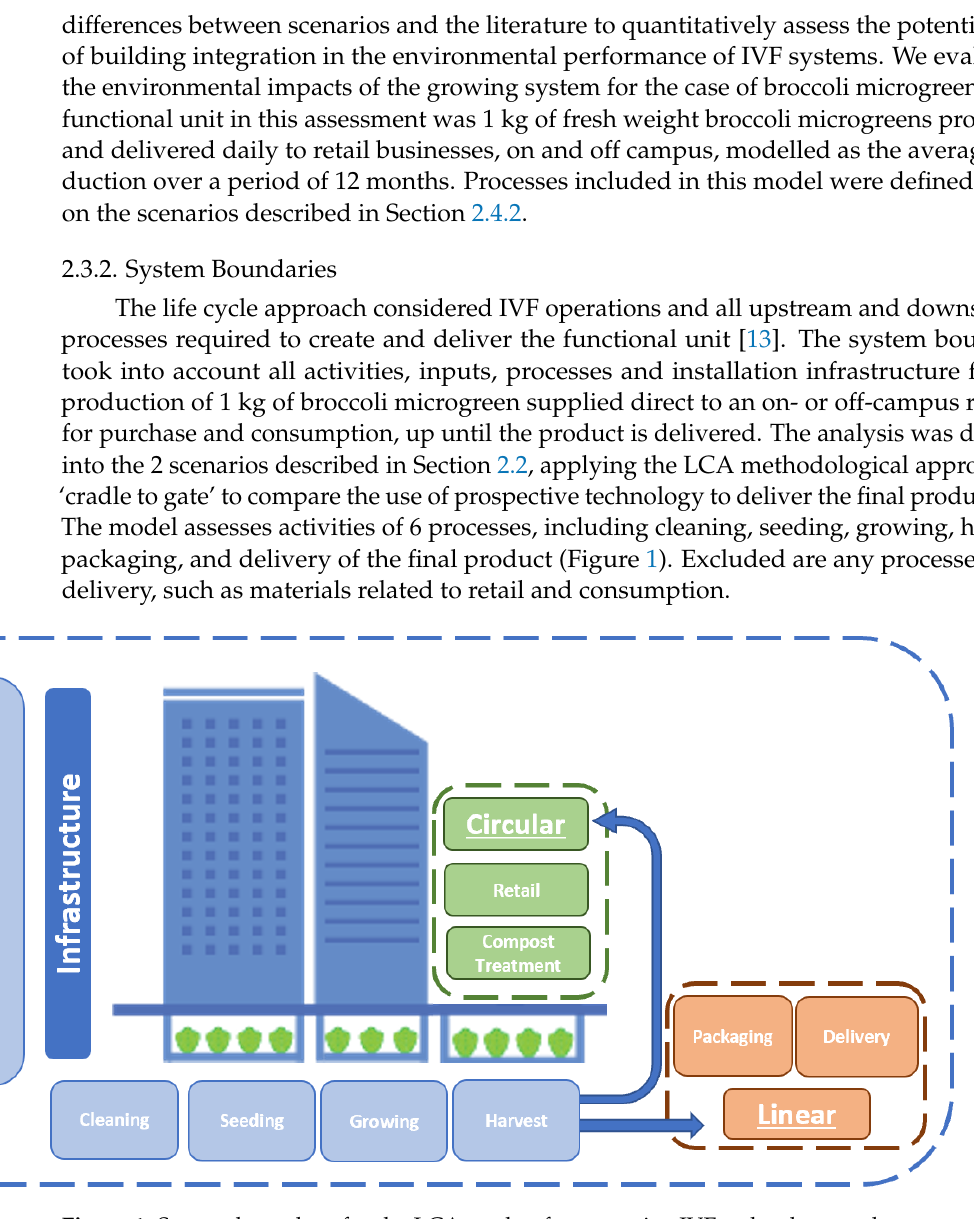
Figure 1. System boundary for the LCA study of prospective IVF technology and processes (Blue) to service through circular supply on campus (Green) for comparison with linear supply (Orange) delivering to offsite retail food businesses.